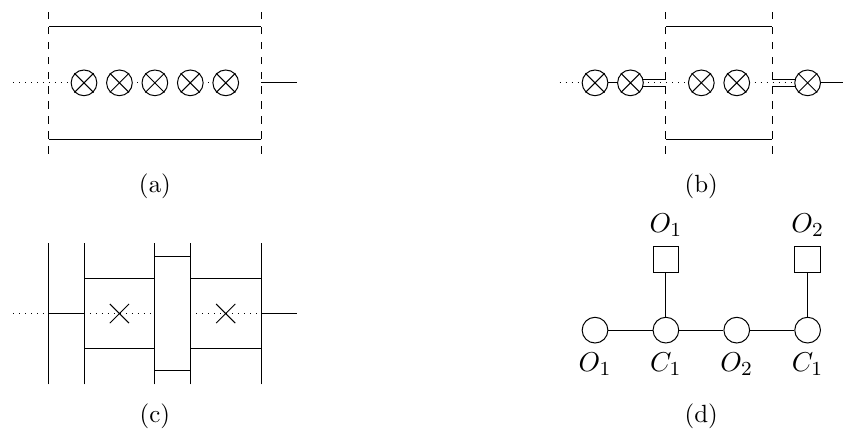
Figure 37. Transverse slice S = A 3 that can be removed via Kraft-Procesi transition. (a) Local brane con(cid:12)guration. (b) Phase transition towards the Coulomb branch brane con(cid:12)guration, two D3-branes are created. (c) Phase transition that obtains the Coulomb branch brane con(cid:12)guration after aligning all D3-branes at the origin and then splitting them so they only end at half NS5- branes, a rotation that takes ~x to ~y and ~y to (cid:0) ~x has been performed. (d) Quiver from (c), the Higgs branch of this quiver is M H = A 3 , see the computation in appendix